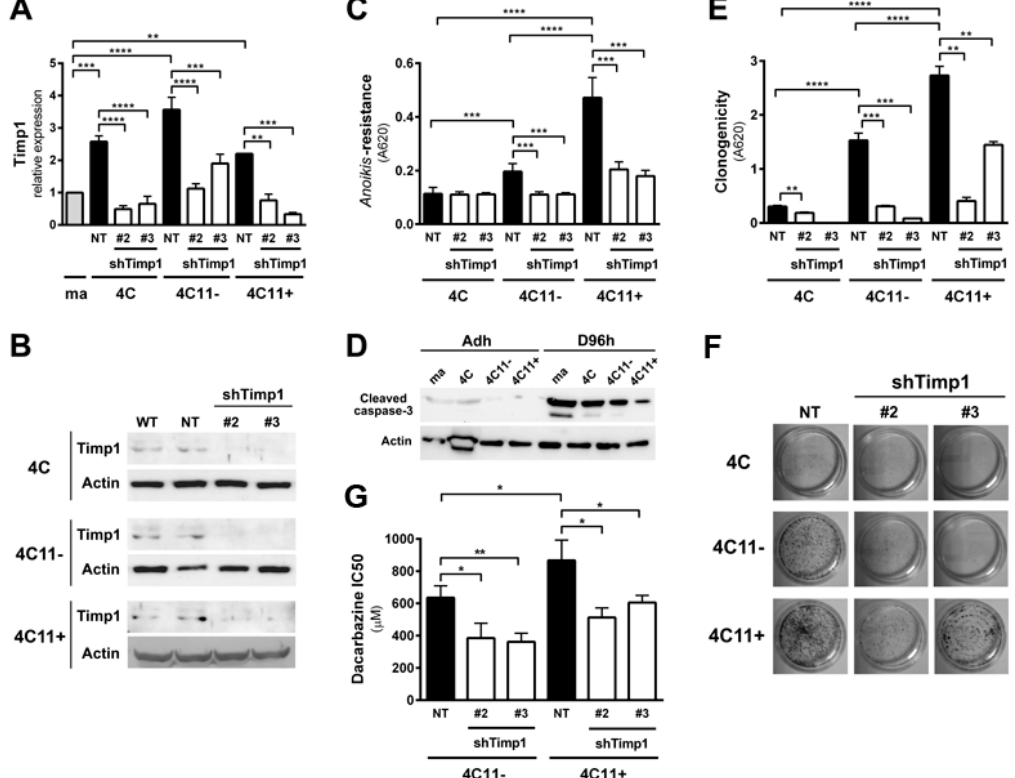
Figure 1. Downregulation of Timp1 decreases cell survival in melanoma cells. ( A , B ) Timp1 mRNA expression was assessed by RT-qPCR and Western blotting, respectively, in different cell lines representing different stages of melanoma progression after transduction with viral particles containing two different shRNA sequences for Timp1 (shTimp1#2 and shTimp1#3) or control non-target shRNA (non-target, NT); ( C , D ) cell lines were maintained in suspension for 96 h and the number of viable cells was estimated, respectively, using MTT and analysis of cleaved caspase-3 by Western blotting; ( E , F ) 200 cells were incubated at 37 °C on 60 mm 2 plates for 10 days. After this period, the clone formation was, respectively, quantified and visualized after toluidine blue staining; and ( G ) the non-metastatic 4C11 − and metastatic melanoma cell line 4C11+ were treated for 48 h with dacarbazine (IC50). After this period, cell viability was analyzed by MTT assay. ma: melan-a melanocytes; 4C: pre-malignant melanocytes; 4C11 − : non-metastatic melanoma cell line; 4C11+: metastatic melanoma cell line; NT: control non-target shRNA; shTimp1#2: clone 2 silenced for Timp1; shTimp1#3: clone 3 silenced for Timp1. * p < 0.05, ** p < 0.01, *** p < 0.001, **** p < 0.0001.